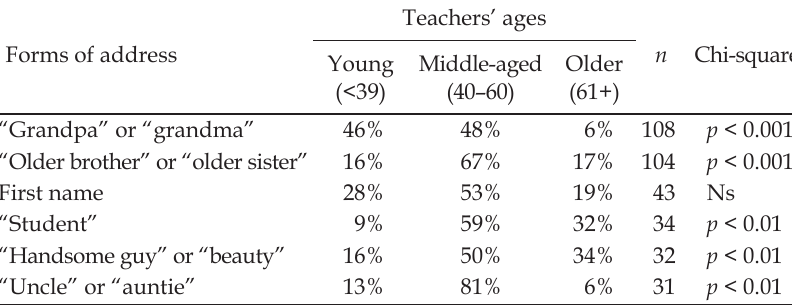
Table 1. Modes of addressing older students, by teachers’ ages ( N =